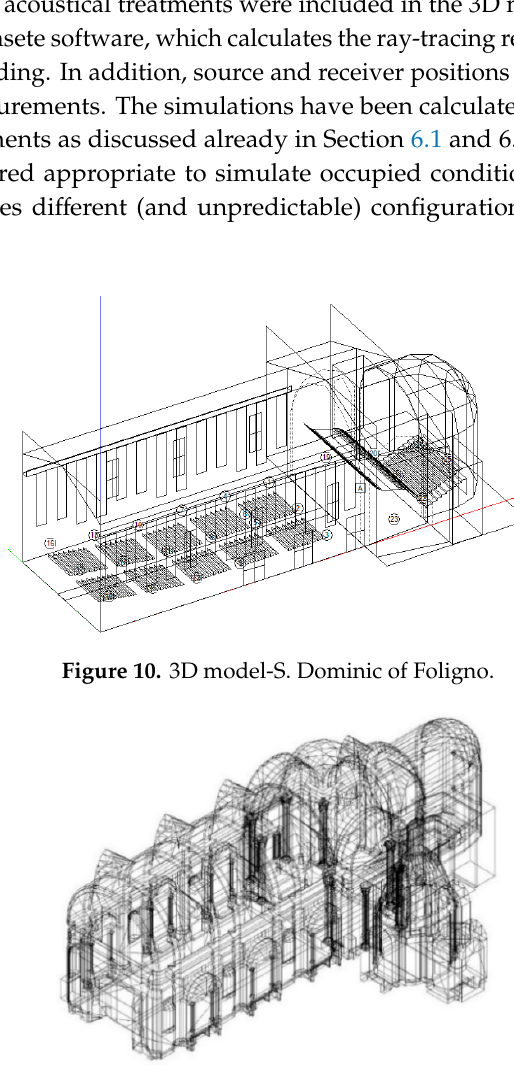
Figure 11. 3D model-S. Dominic of